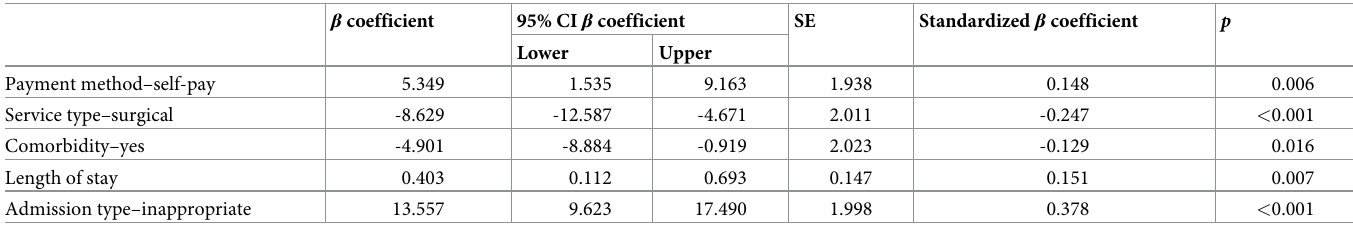
Table 4. Multivariate regression analysis of the percentage of inappropriate hospital days.